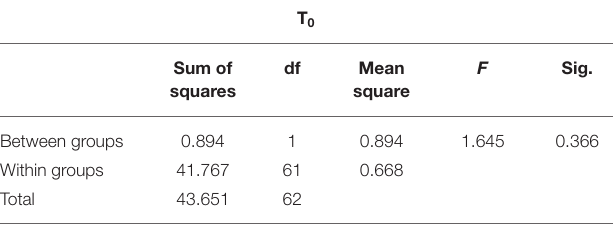
TABLE 3B | Emotional conditions of two gender groups after inducement.